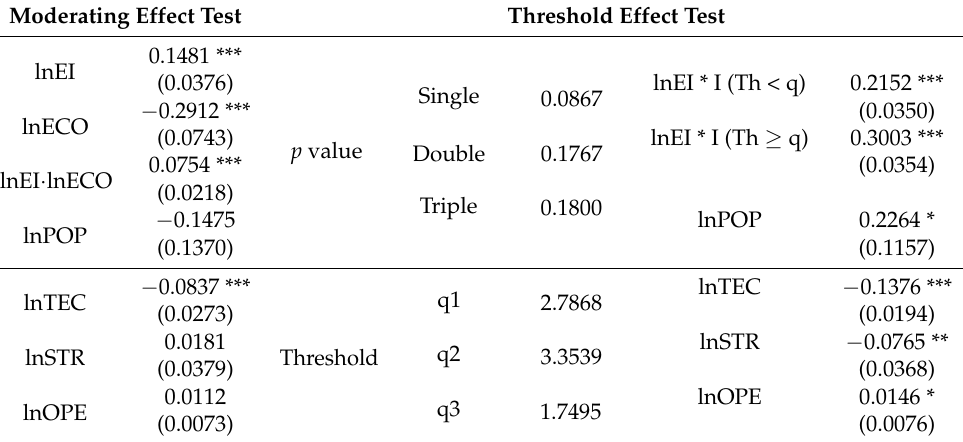
Table 8. The test for the moderating effect and the threshold effect of economic development. Moderating Effect Test